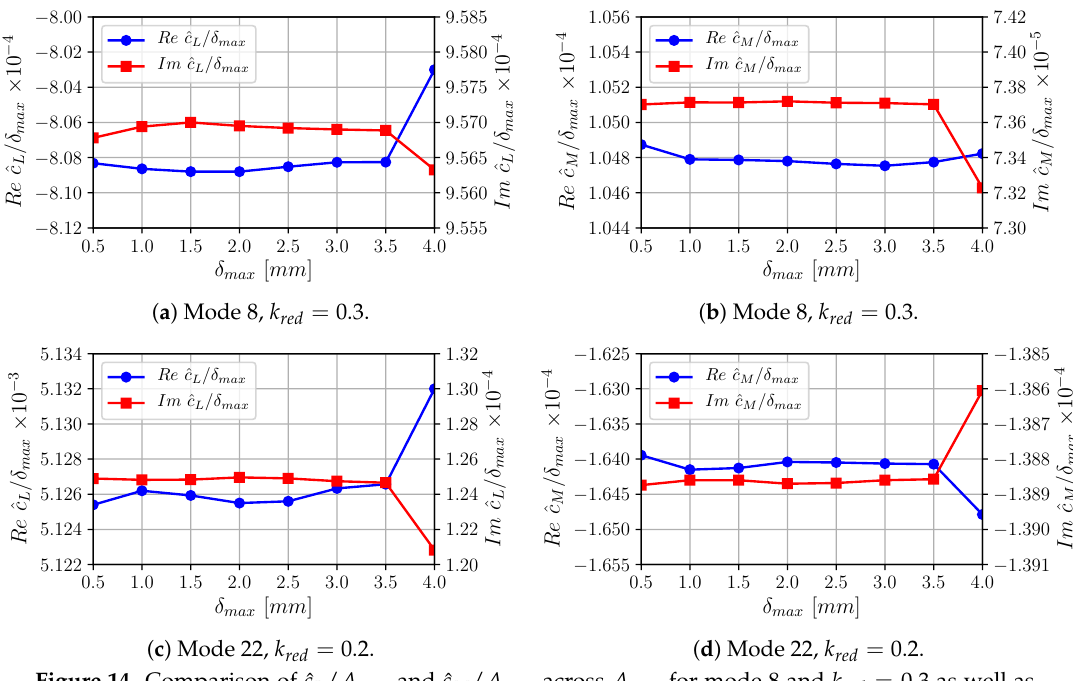
Figure 14. Comparison of ˆ c L / A max and ˆ c M / A max across A max for mode 8 and k red = 0.3 as well as mode 22 and k red =